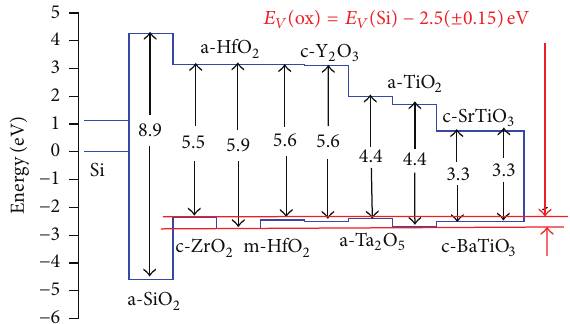
Figure 10: Schematic of band alignment at the interfaces of silicon with oxides of several transition and rare-earth metals as compared to the Si/SiO 2 interface. The diagrams are shown for amorphous (a-) and crystalline (c-) phases. The origin of the energy scale is located at the top of the silicon